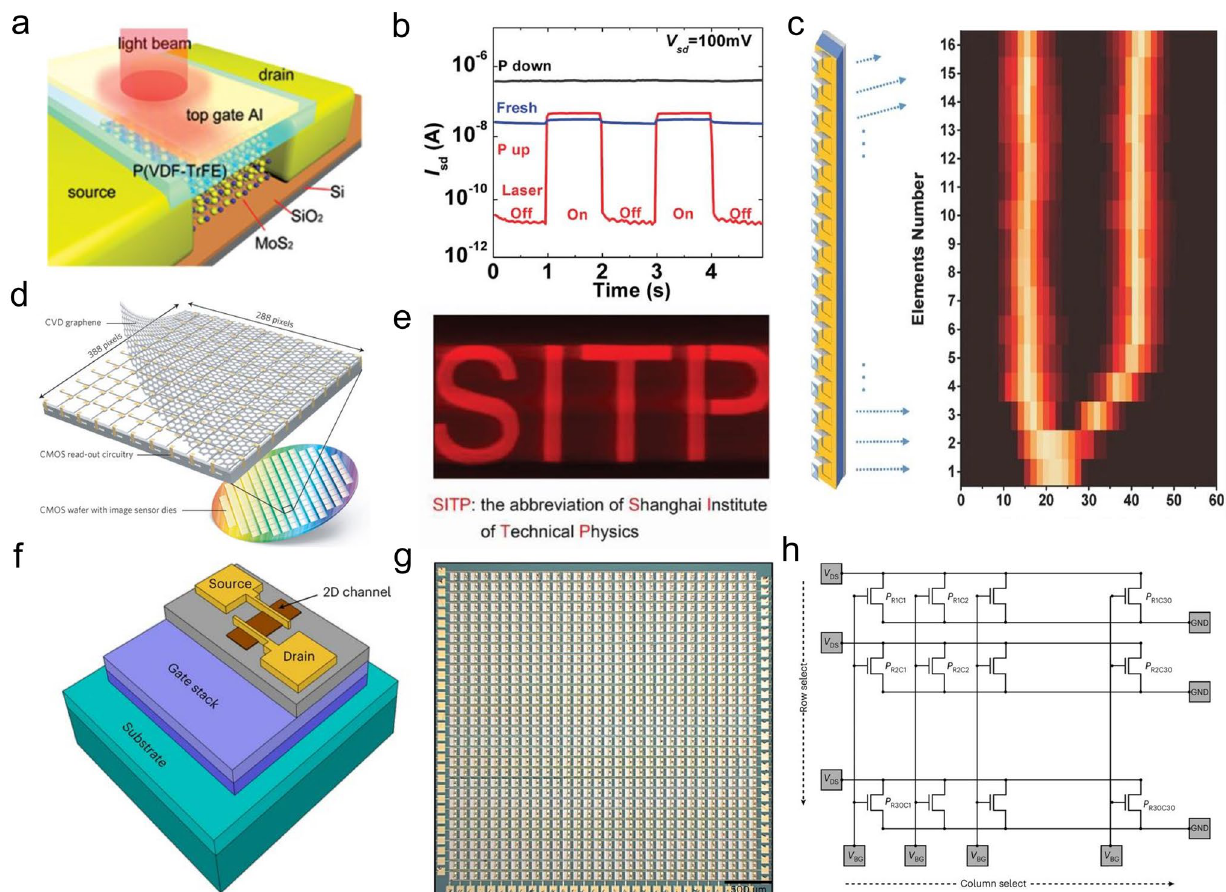
Fig. 12 2D materials-based photodetector. a Schematic diagram of the ferroelectric enhanced MoS 2 -based photodetector, b MoS 2 current as the function of the ferroelectric polarization [146], Copyright 2015, WILEY–VCH. c Graphene-based photodetector array [169], Copyright 2017, Springer Nature. d Infrared image obtained from single-pixel imaging setup prepared by the MoS 2 photodetector [155], Copyright 2019, WILEY–VCH. e The infrared image obtained from linear array imaging (16 × 60 pixels) by using GaSe/GaSb heterostructures [170], Copyright 2017, WILEY–VCH. f–h ) The monolayer MoS 2 phototransistor-based active pixel sensor array [168], Copyright 2022, Springer